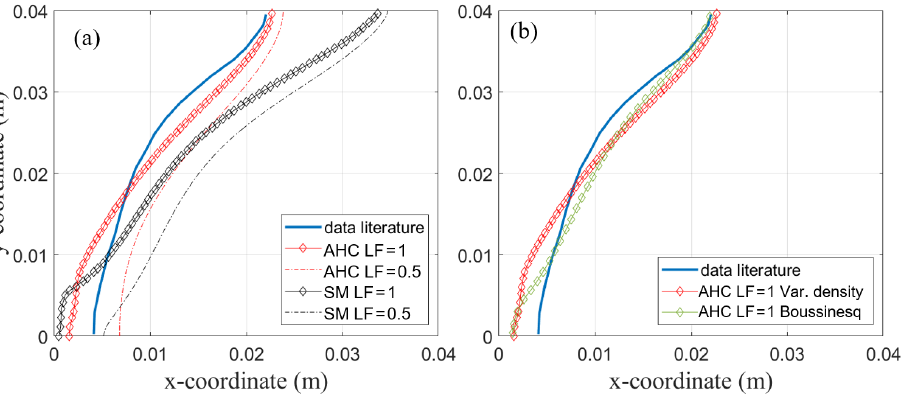
Figure 12. ( a ) Phase front visually measured after t = 2h provided in [2]. ( b ) Comparison of AHC model with variable density and Boussinesq approximation for data from